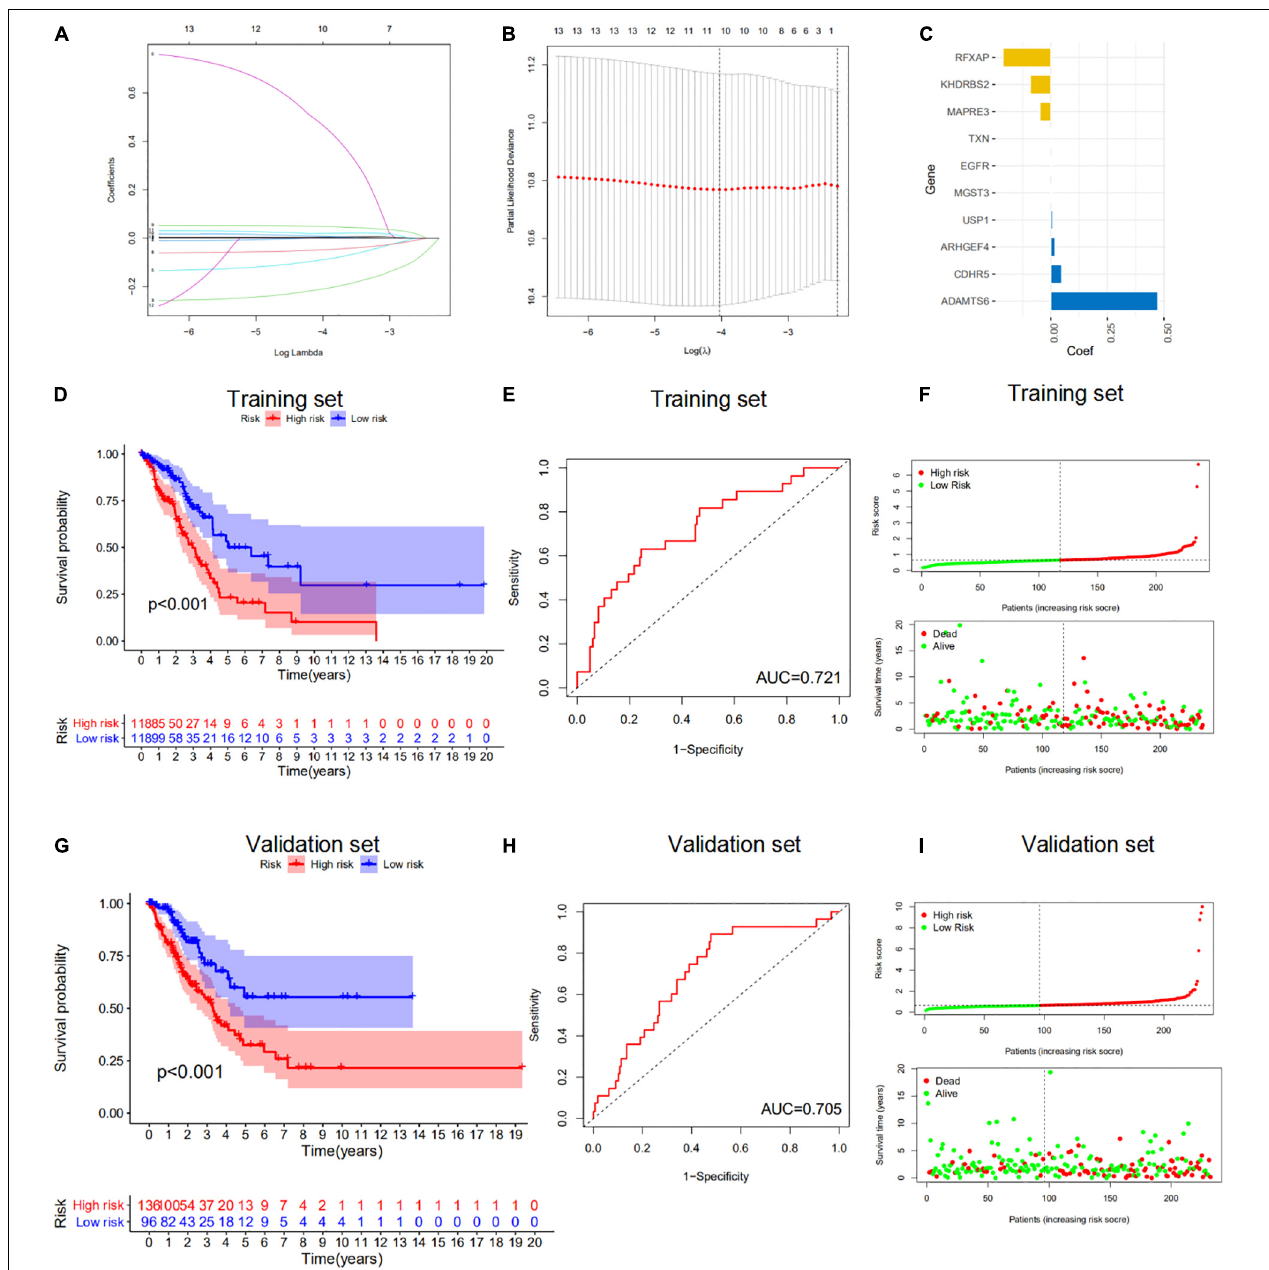
FIGURE 5 | Evaluation of the prognostic performance of the m6A-regulated mRNAs. (A–C) Least absolute shrinkage and selection operator (LASSO) regression was performed to calculate the minimum criteria (A,B) and coefficients (C) . (D,G) Kaplan–Meier survival analysis of high-risk (red) and low-risk (blue) LUAD patients in the training set and validation set. (E,H) The receiver operating characteristic curve (ROC) analysis for the prognosis prediction of the signature of overall survival (OS) in the training set and validation set and the area under curve (AUC) was calculated. (F,I) Distributions of risk scores and survival status of LUAD patients in the training set and validation